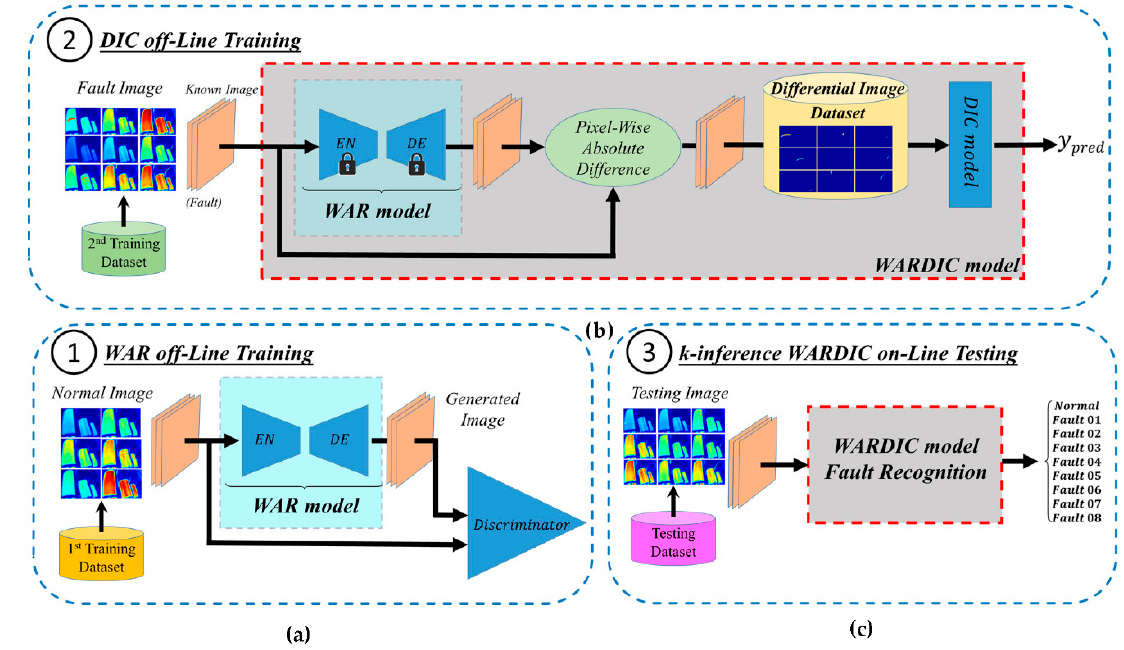
Figure 2. Block diagram of the proposed method: ( a ) the WAR model off-line training. ( b ) The DIC model off-line training. ( c ) k-inference the trained WAR-DIC on-line testing.